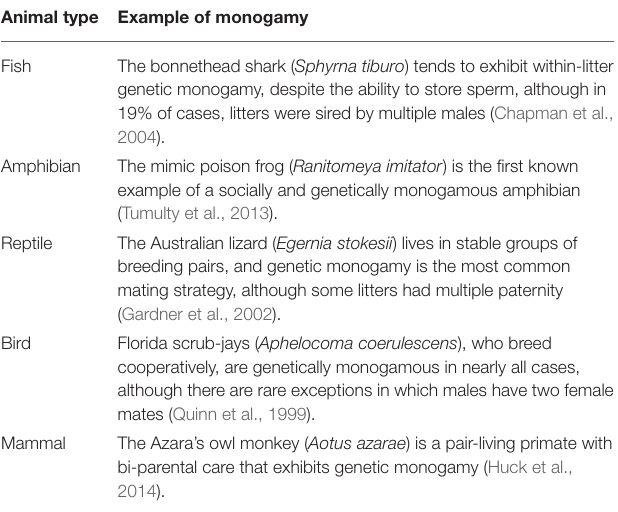
TABLE 1 | Examples of monogamy in nature. Animal type Example of